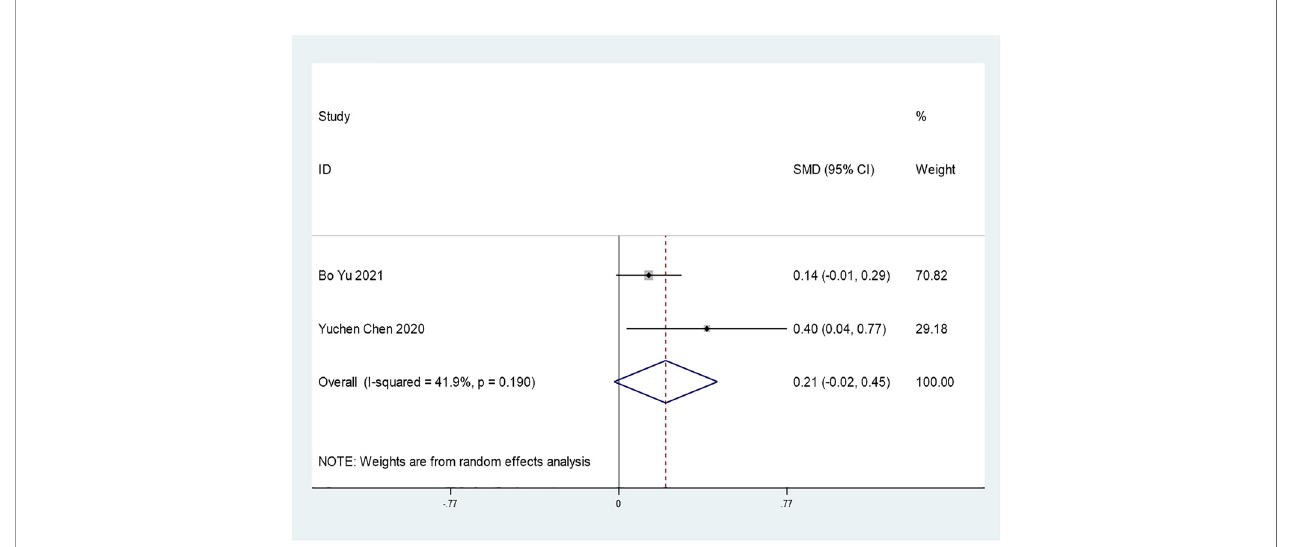
FIGURE 7 | Forest plots of SMD for the association between the insulin treatment and the hospitalization time of